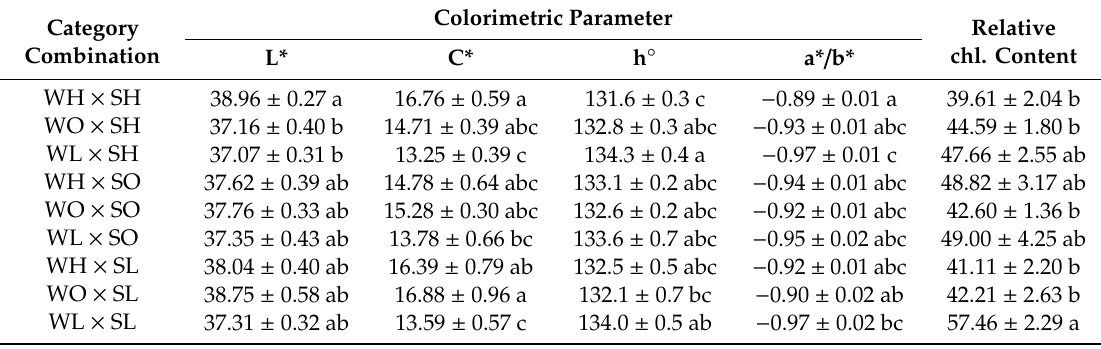
Table 3. Colorimetric parameters and relative chlorophyll content of grafted watermelon seedlings from nine quality category combinations obtained 14 days after grafting, as described in Table